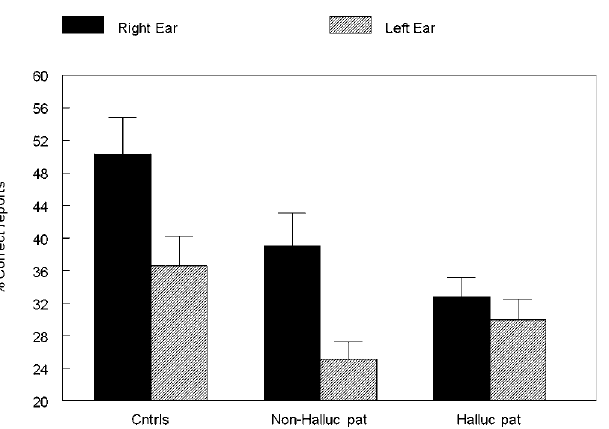
Figure 3. Percent correct reports on the CV-syllables DL paradigm split for healthy controls, patients with ongoing and patients with previous auditory